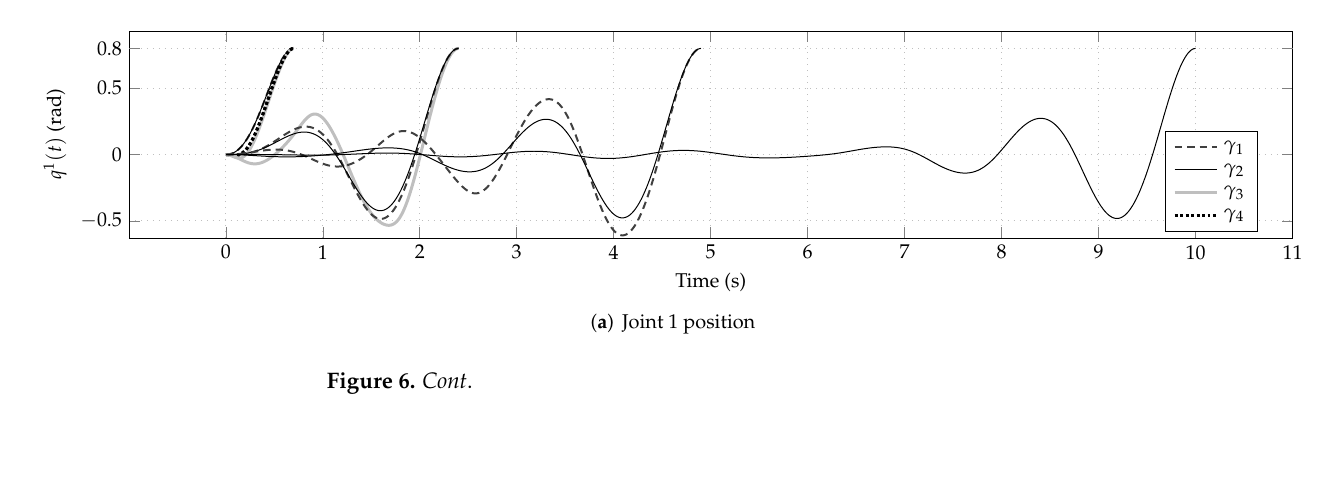
Figure 5. Comparison of positions along optimal trajectories, resulting from invariant running cost functions ( γ 1 and γ 2 ) versus non-invariant ones ( γ 3 and γ 4 ). Functions γ 1 and γ 3 share a torque criterion; functions γ 2 and γ 4 share a torque plus velocity criterion. The invariant running cost functions stabilize motion by narrowing angular amplitude. ( a ) Joint 1 positions with γ 1 and γ 3 for the upward motion. ( b ) Joint 2 positions with γ 1 and γ 3 for the upward motion. ( c ) Joint 1 positions with γ 2 and γ 4 for the upward motion. ( d ) Joint 2 positions with γ 2 and γ 4 for the upward motion. ( e ) Joint 1 positions with γ 1 and γ 3 for the downward motion. ( f ) Joint 2 positions with γ 1 and γ 3 for the downward motion. ( g ) Joint 1 positions with γ 2 and γ 4 for the downward motion. ( h ) Joint 2 positions with γ 2 and γ 4 for the downward motion.